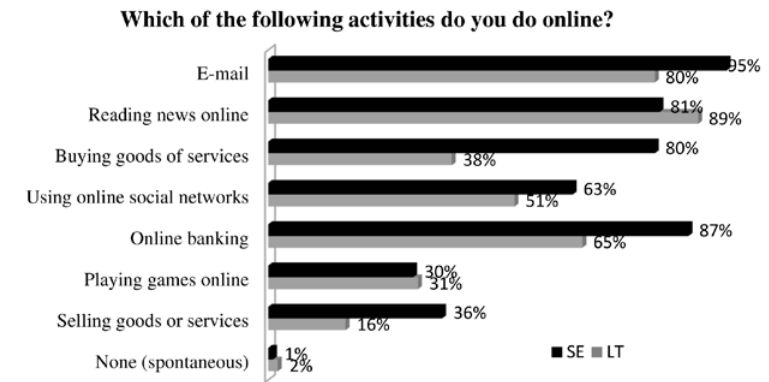
Fig. 1. Preferences of online activities in Sweden and Lithuania Source: Special Eurobarometer 390, “Cyber Security”: Report